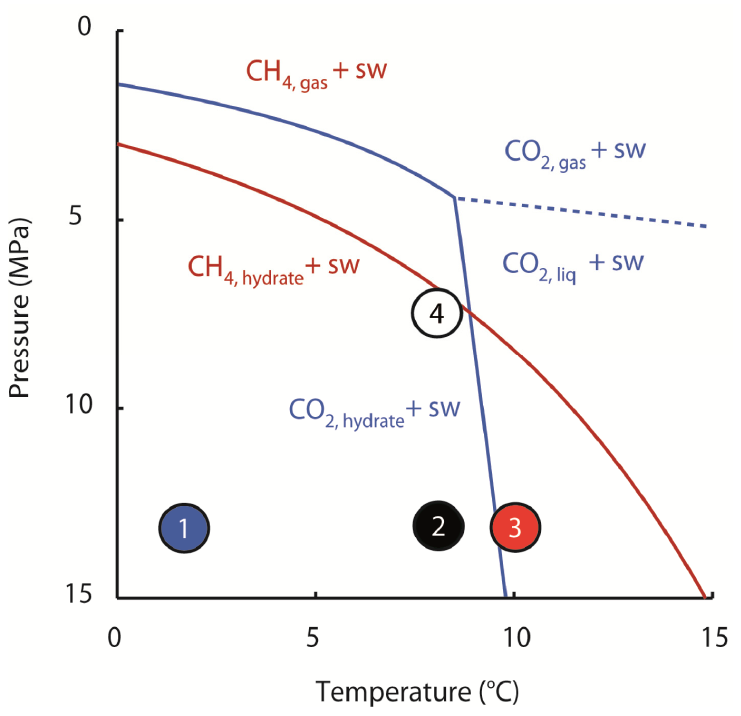
Figure 2. Experimental conditions, stability of CH the CH -H O (red) and the CO 4 2